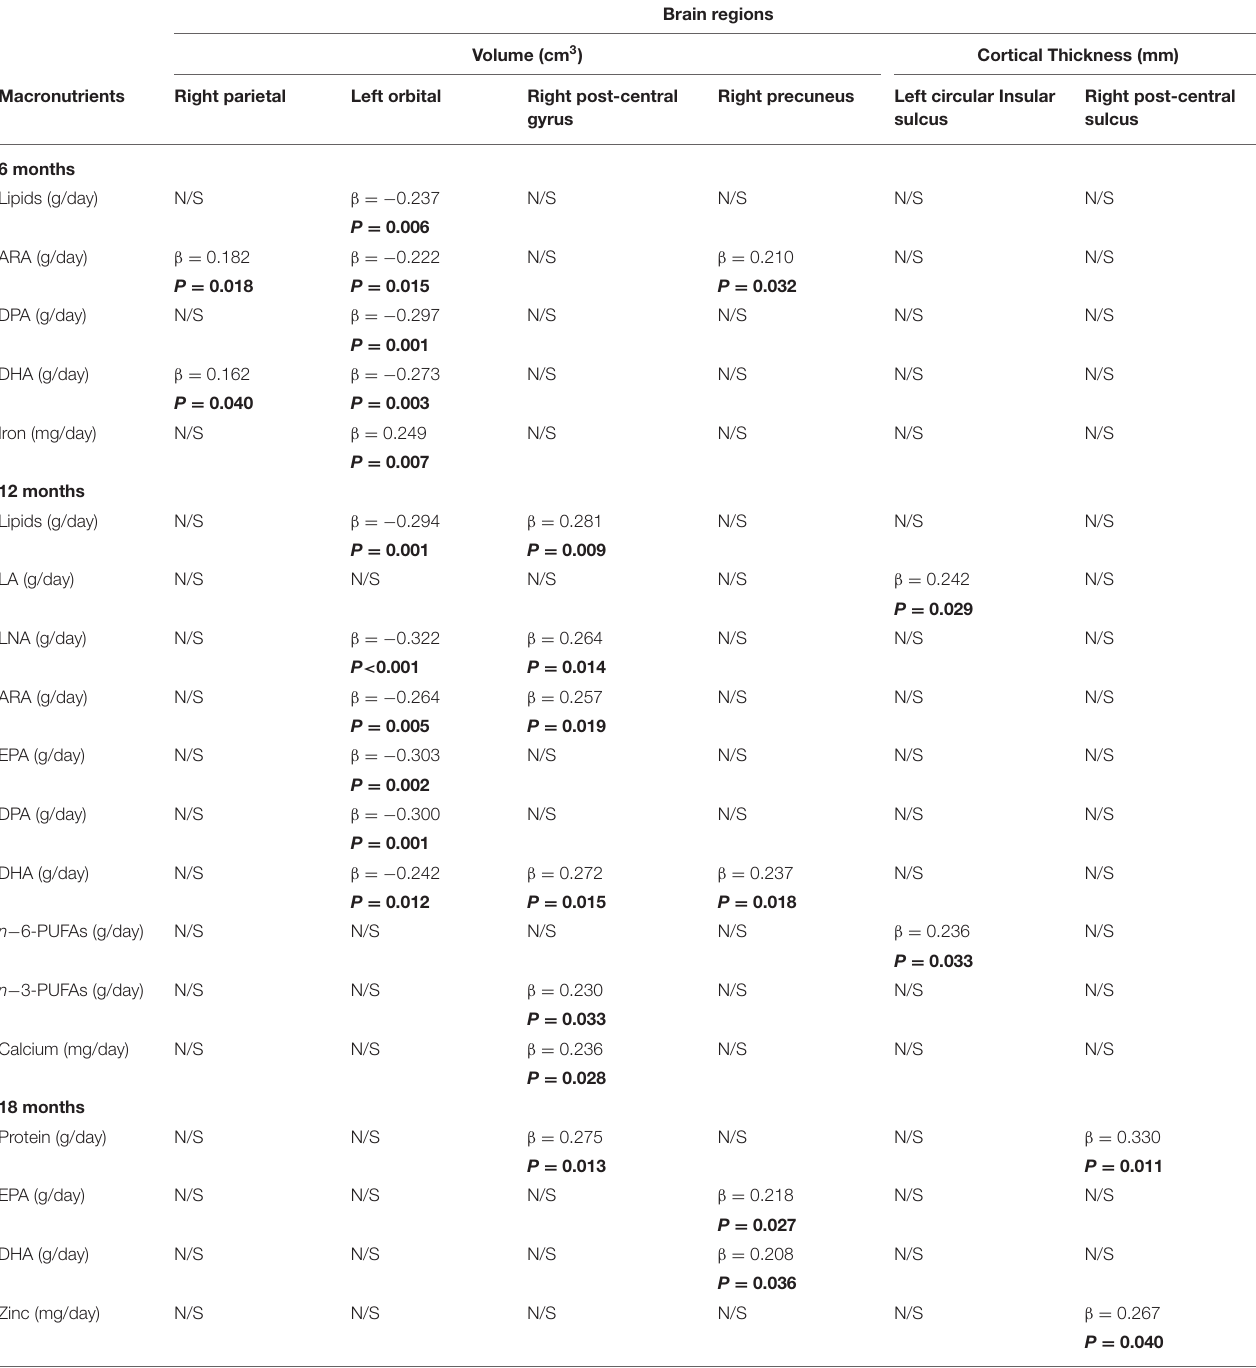
TABLE 7 | Long-Term influence of early dietary intake on brain structure in children aged 6 years a . Macronutrients Right post-central